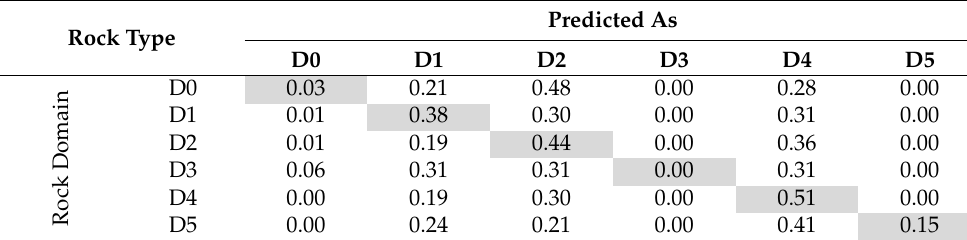
Table 11. Confusion matrix for 2D RF modeling for